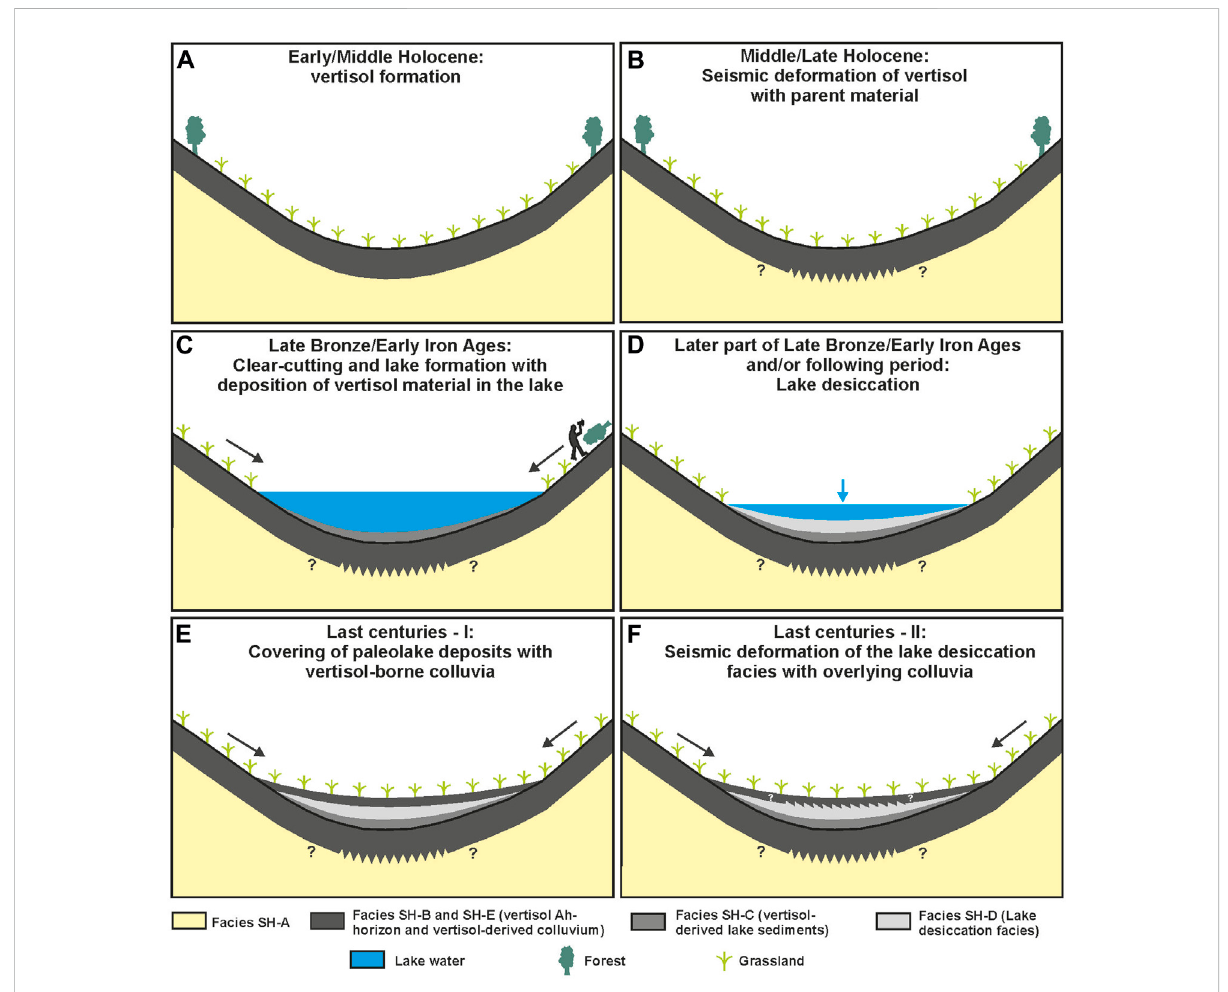
FIGURE 9 Landscape evolutionoftheShiraki Plain: (A) Early/Middle Holocene. (B) Middle/Late Holocene. (C) Late Bronze/Early Iron Ages. (D) Later partof Late Bronze/Early Iron Ages and/or following period. (E) Last centuries – I. (F) Last centuries –